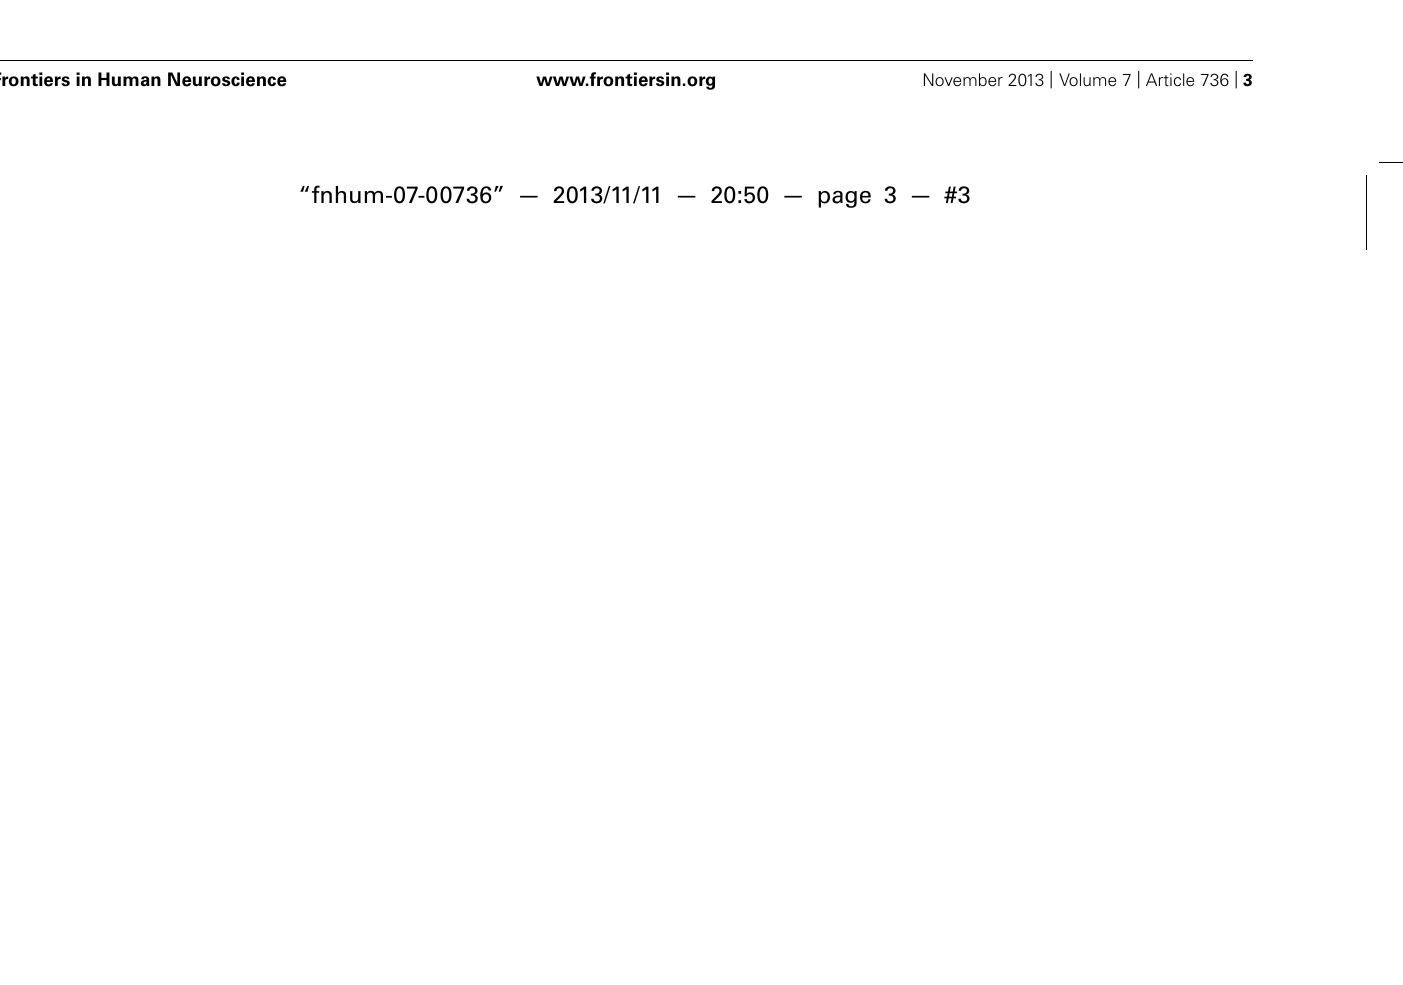
FIGURE 1 | Experimental setup. (A) TMS setup and task display. Participants were seated in front of the computer display and responded by pressing the space bar with the right index finger. The test coil was placed over the left M1 and the conditioning coil was placed over rIFC. EMG was recorded continuously from the right hand